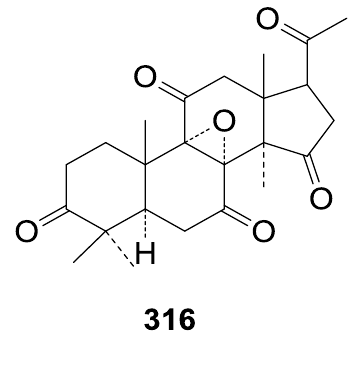
Figure 40. Structure of compound 316